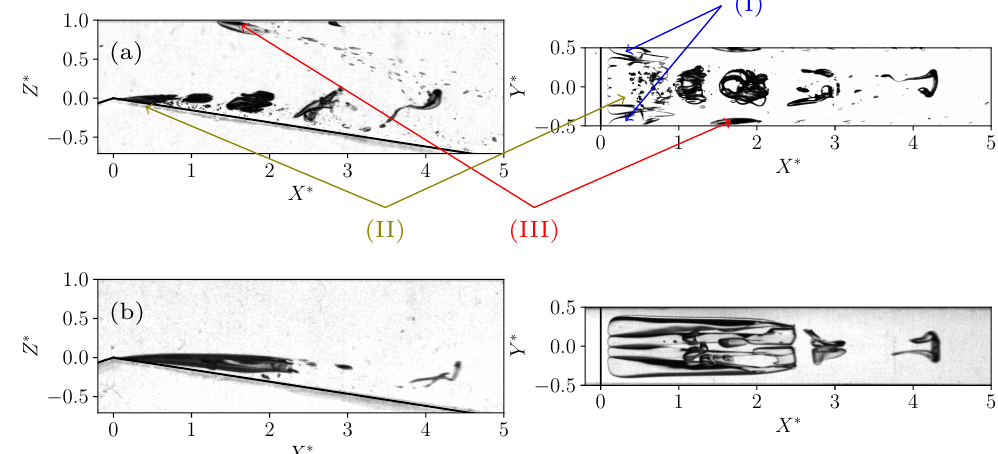
Figure 5. Comparison between two experiments performed at similar Reynolds numbers ( Re and cavitation numbers ( σ 2 1.5) with a different degassing protocol. ( a ): Silicone oil is saturated (cid:39) with air at 1 bar before running the experiment. The three types of gaseous structures are spotted with (I) for bottom tadpoles, (II) for attached sheet cavity and (III) for top tadpoles. ( b ): Silicone oil is first degassed at 70 mbars; an attached sheet cavity is only